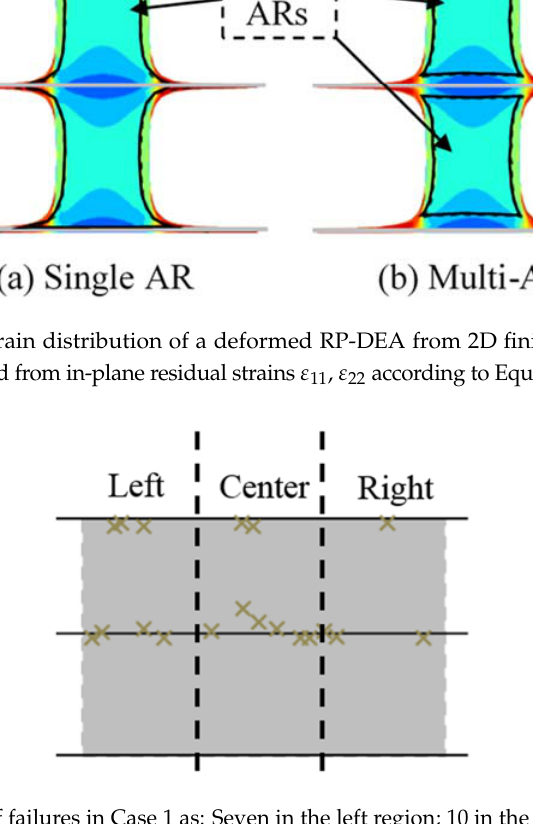
Figure 13. Occurrence of failures in Case 1 as: Seven in the left region; 10 in the center region and three in the right region of the AR (Figure 8a).